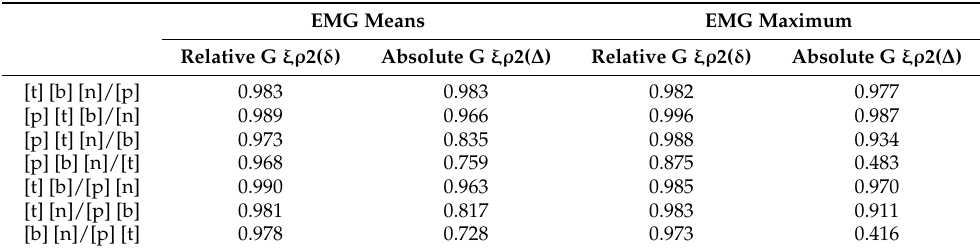
Table 2. Generalizability analysis (G coefficients).